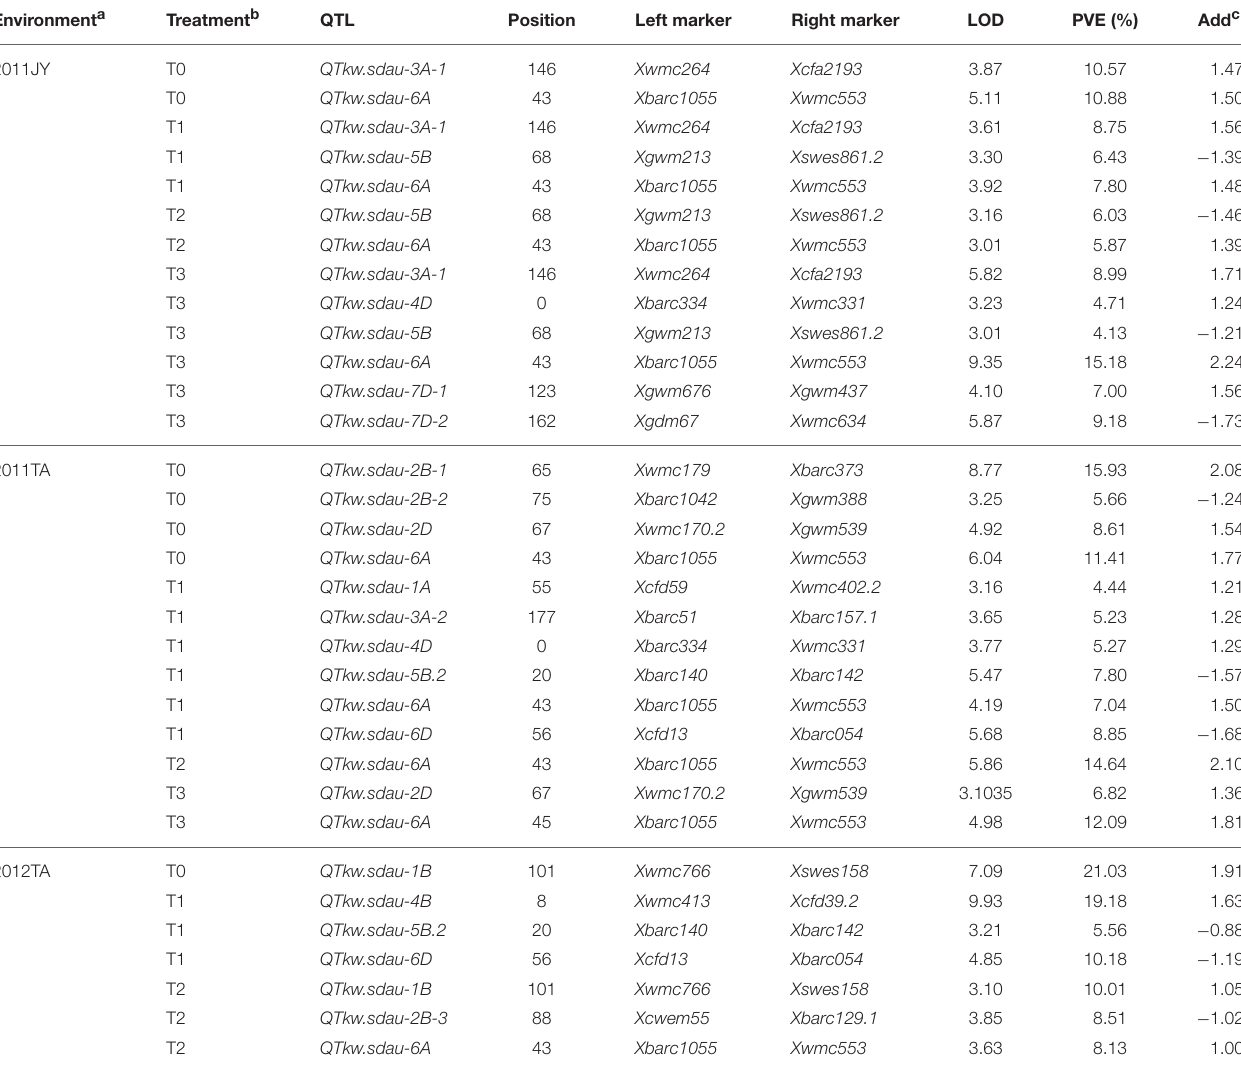
TABLE 8 | Additive QTLs for thousand-kernel weight identified under different nitrogen supplying dates in different years. Environment a Treatment